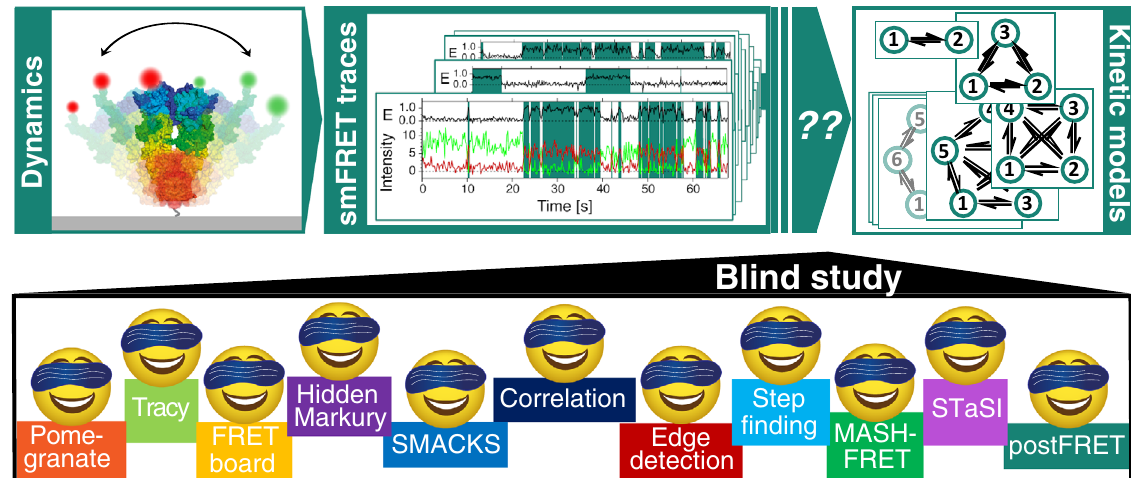
Fig. 1| Thisblindstudyreportsontheperformanceofdiverseanalysistoolsto describe single-molecule dynamics with quantitative kinetic rate constants. Biomolecular dynamics of proteins and nucleic acids can be detected by smFRET andothersingle-moleculetechniques.Extractingtestablekineticratemodelsfrom